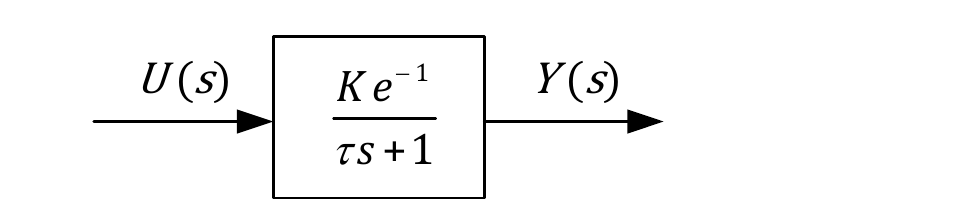
Figure 3. Transfer function in the Laplace that represents the linearized tank in the operation point ( h S , Q s ).